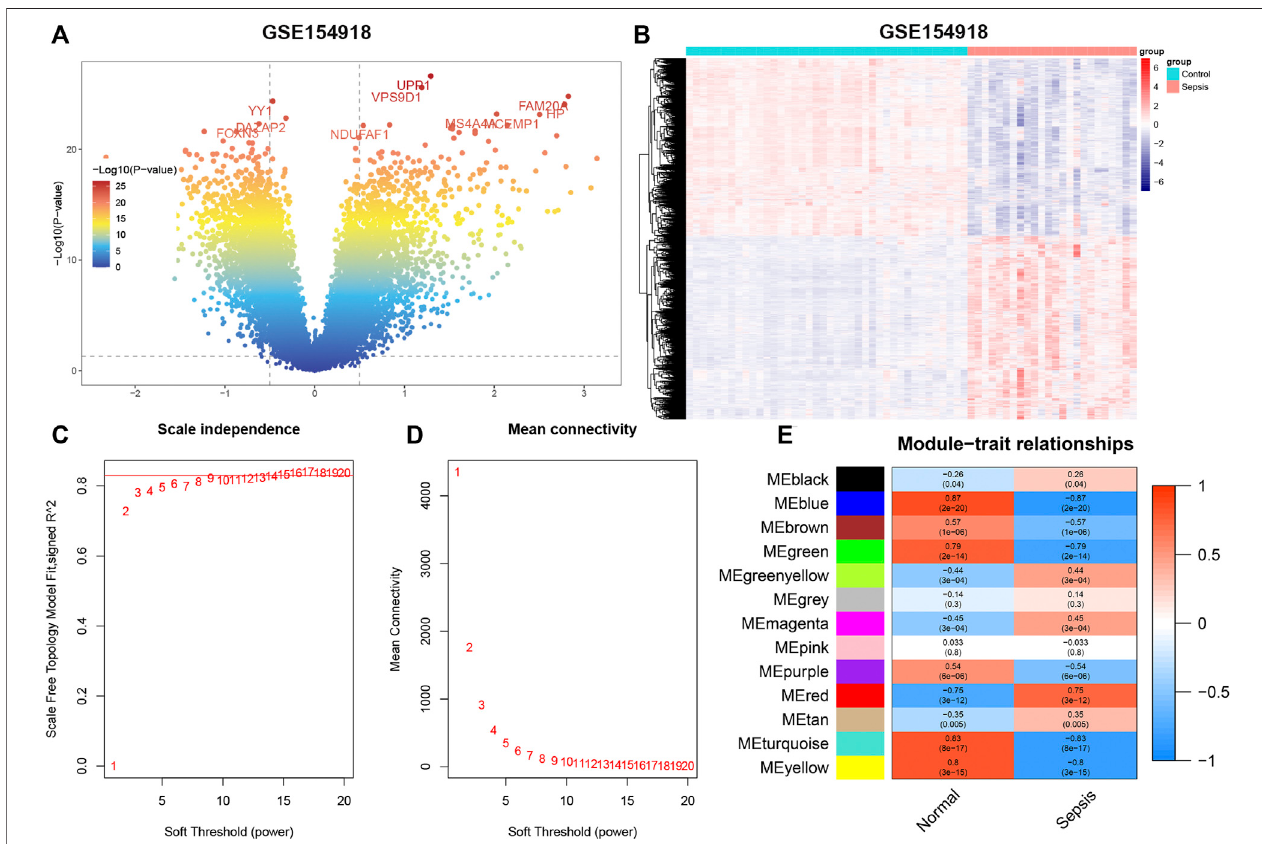
FIGURE 2 | GSE154918 datasets analyzed by DEGs and WGCNA methods, respectively. (A) Representative volcano plot in GSE154918 dataset. (B) Representative heat map of DEGs between normal subjects and sepsis patients. (C,D) Soft threshold selection process. (E) Correlation of modules with clinical characteristics. Each row represents adistinct module;each column represents adistinct clinical phenotype. Red rectangle indicates positivecorrelation;blue rectangle indicates negative correlation.